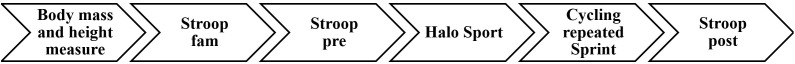
Time line of one experimental trial. Stroop fam, familiarization trials; Stroop pre, Stroop task at baseline; Stroop post, Stroop test after Halo Sport stimulation.